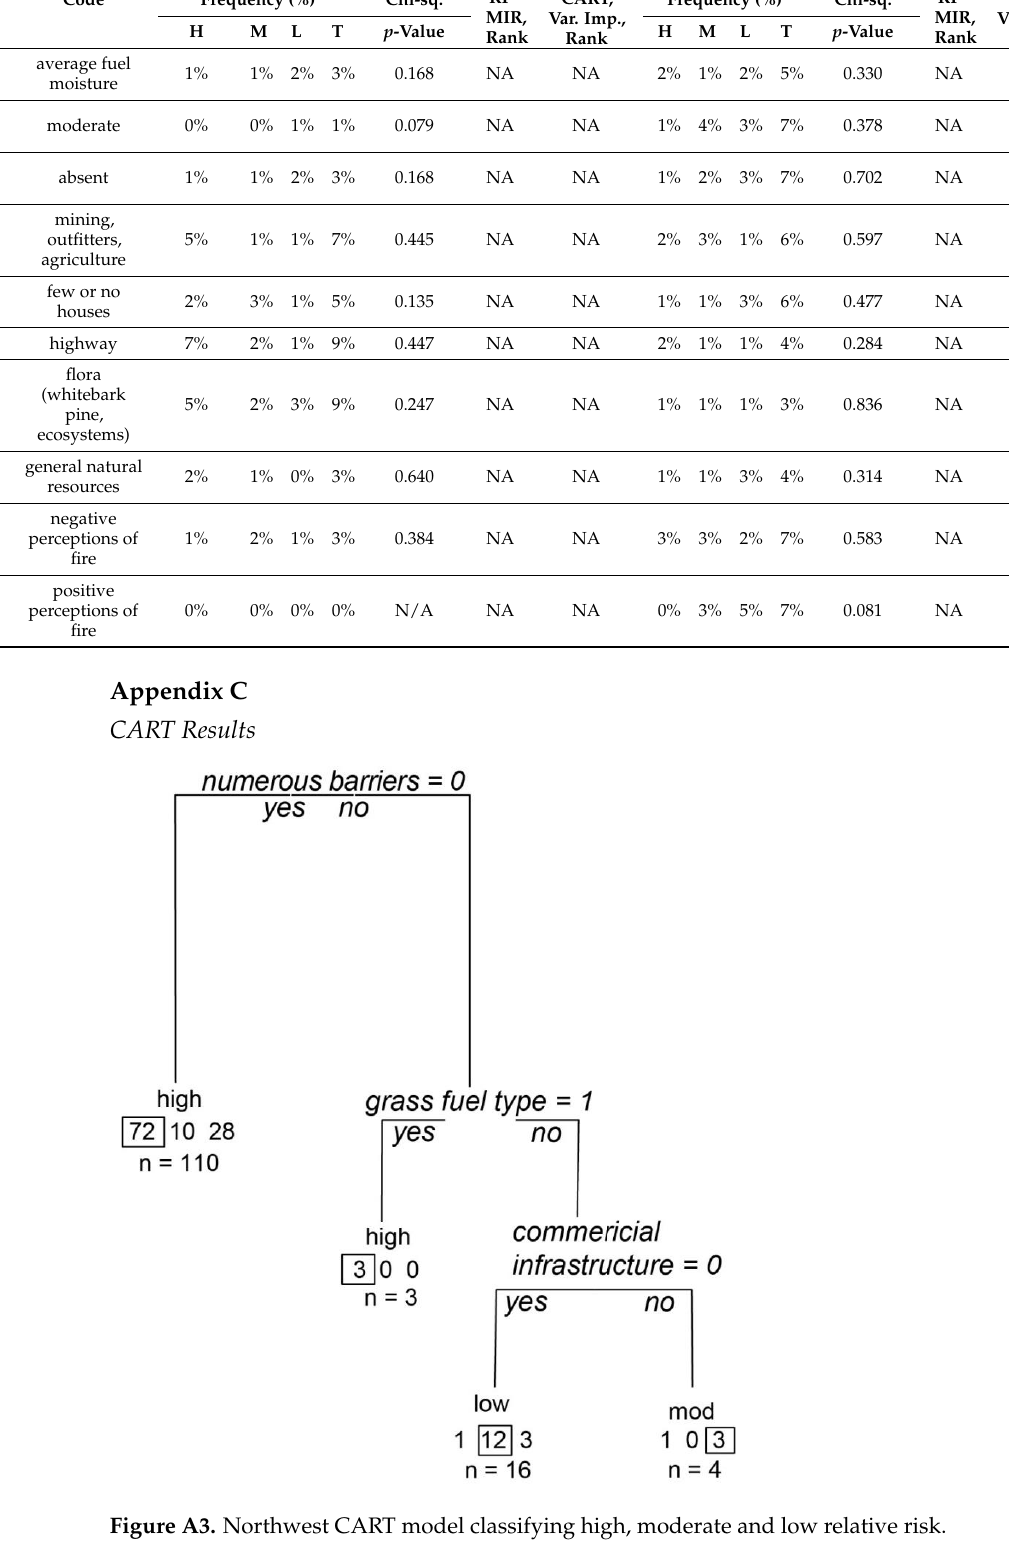
Figure A4. Southwest CART model classifying high, moderate and low relative risk.